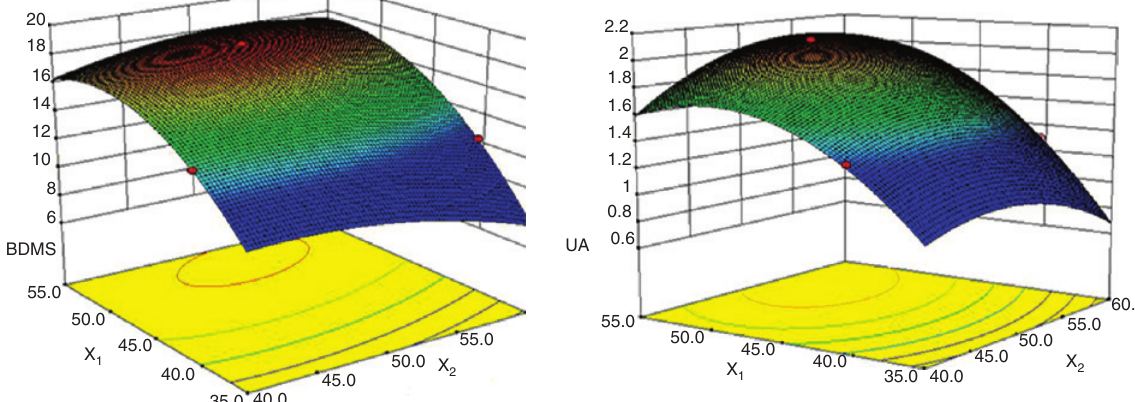
Figure 5: Response surface plots for yield of β , β -dimethylacryl shikonin (BDMS) and ursolic acid (UA) showing the effect of operational parameters ( X , concentration of sucrose; X , temperature). 1 2